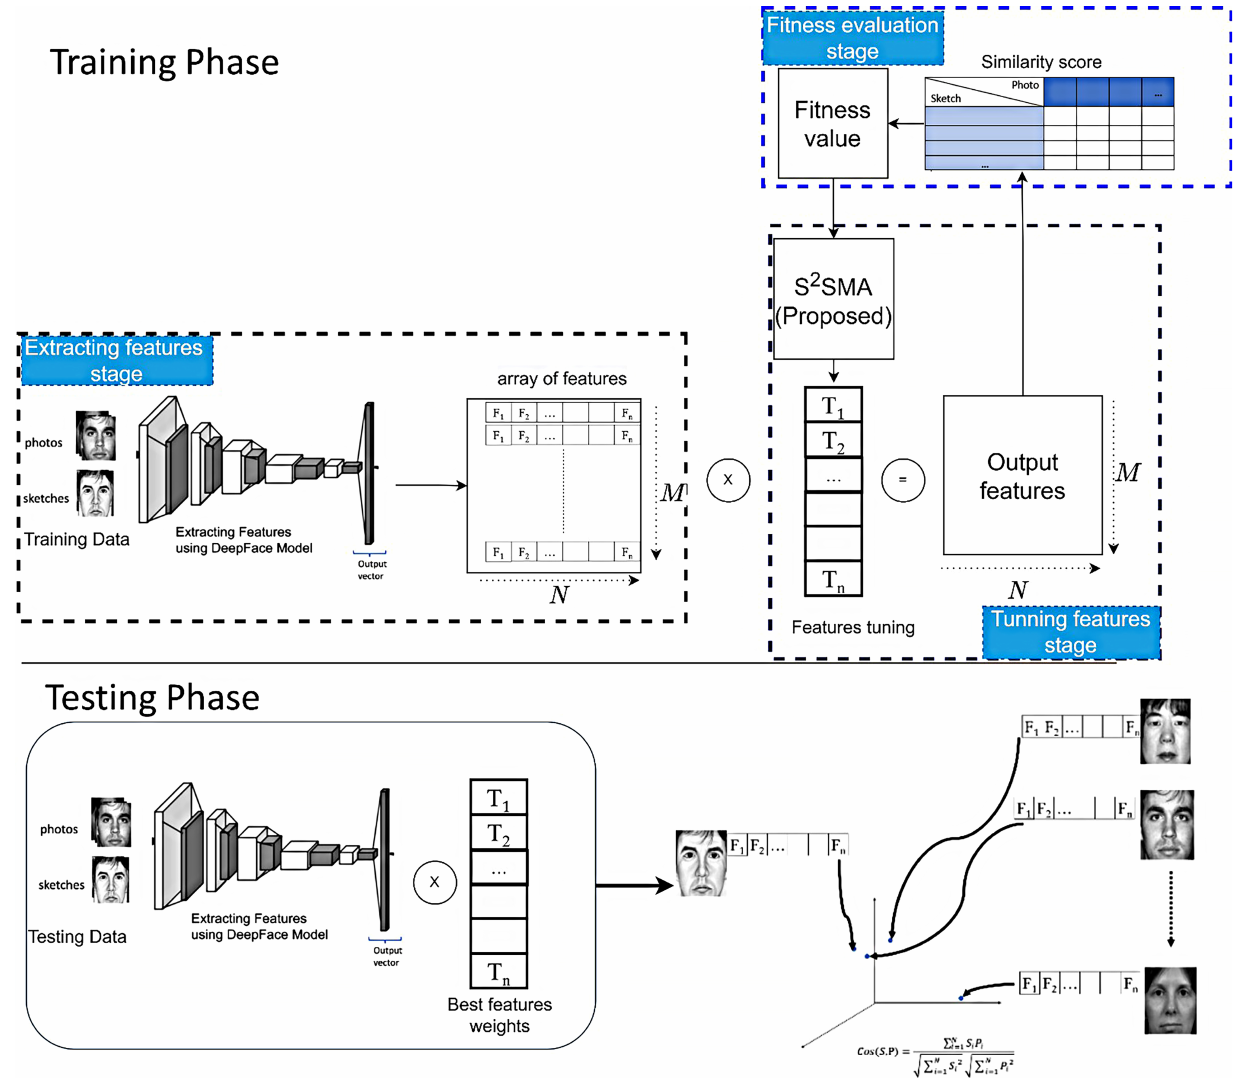
Figure 7. The illustration shows the suggested technique for face sketch recognition using a single deep-face model. The upper portion represents the training phase, while the lower portion represents the testing phase.